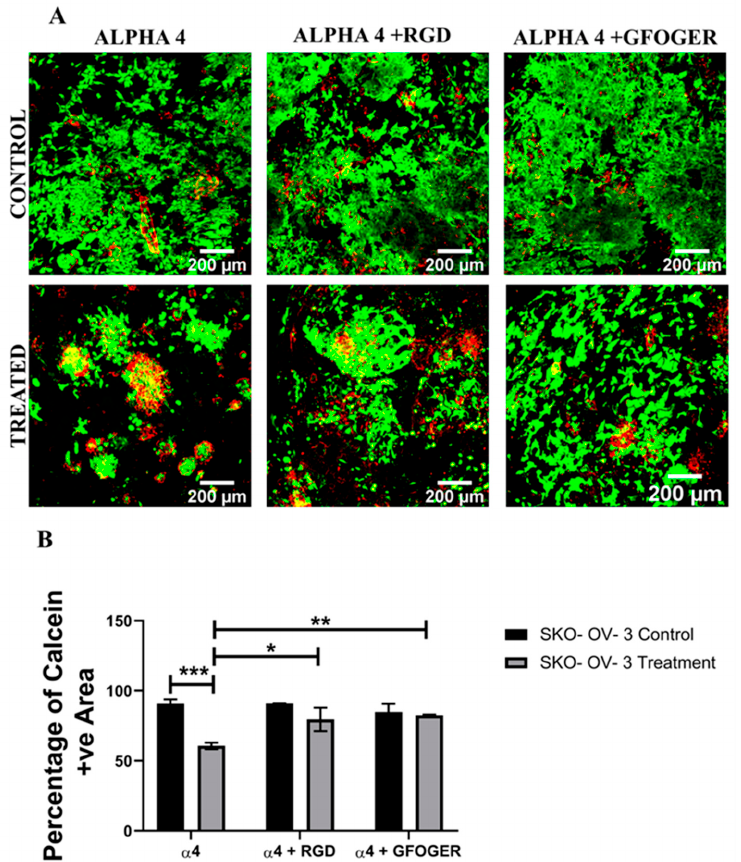
Figure 4. Effect of the chemotherapeutic Cisplatin on the viability of SK-OV-3 EOC cells grown in different PeptiGels, 24 h post-treatment ( A ): Representative images for live–dead (green–red) staining for both treated and untreated (control) SK-OV-3 PeptiGels. ( B ) Image analysis-based quantification of live (green) image areas for SK-OV-3 cells grown in the PeptiGels. Scale bar = 200 μ m. Quantitative data represent mean ± SEM for multiple images ( ≥ 3) and multiple hydrogels ( ≥ 3). * p ≤ 0.05, ** p ≤ 0.01, *** p ≤ 0.001 .